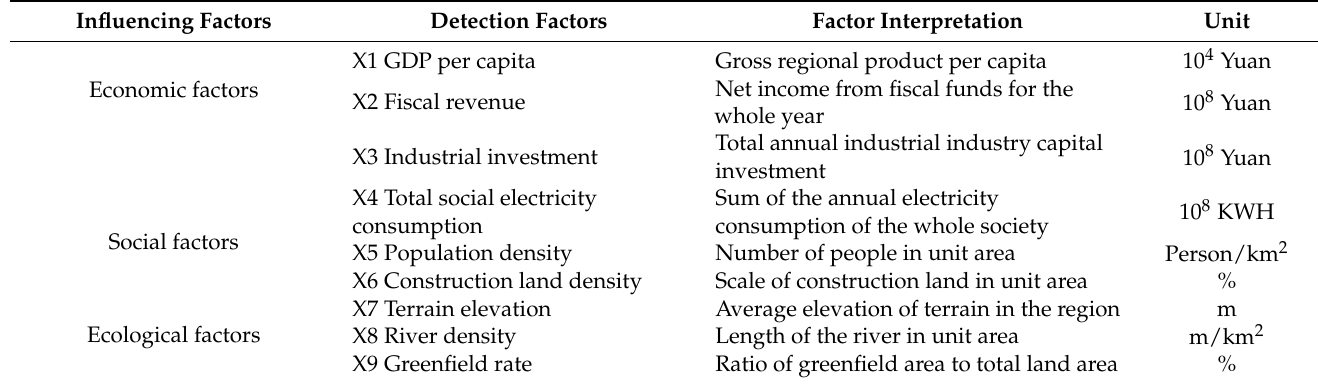
Table 3. Factors influencing the development performance of small towns in Jiangyin.